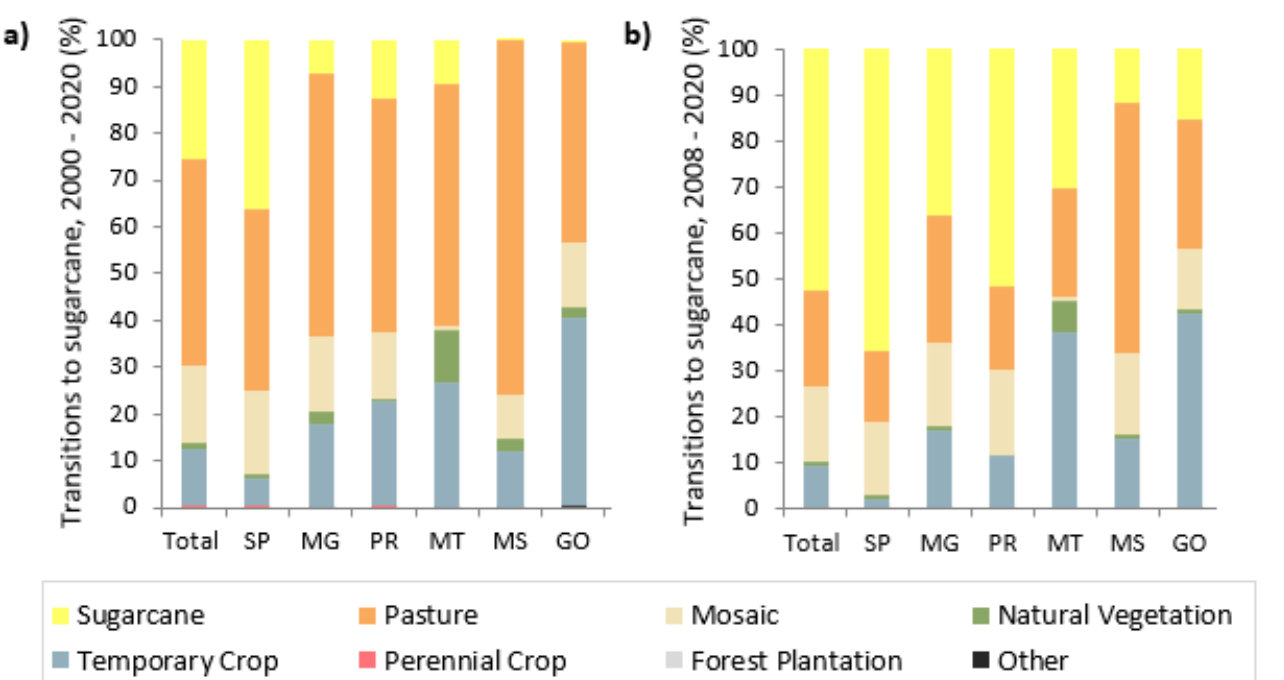
Figure 4. LUCs observed within the whole CARs area with sugarcane cultivation, in Brazil’s center– south and north regions, during the 2000–2020 and 2008–2020 periods. All detailed LUCs are pre- sented in Supplementary Material S1.